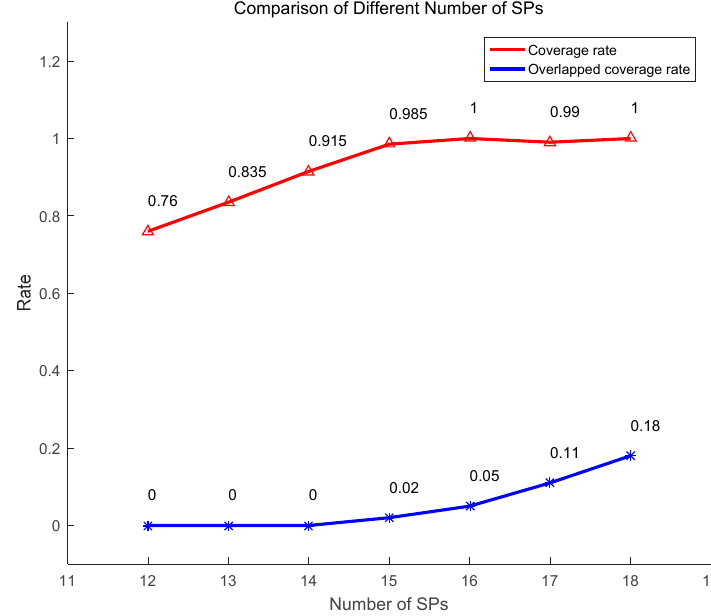
Figure 13. Comparison of di ff erent numbers of